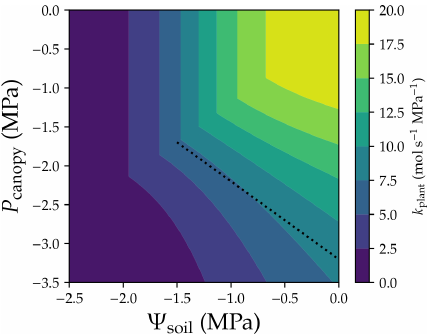
Figure 5. Whole-plant vulnerability surface. Whole-plant hydraulic conductance is computed using k plant = E . The (cid:57) soil − P canopy − ρgh dotted line plots the scenario when mean xylem water pressure is − 1 . 6MPa. The simulation is done assuming there is no drought legacy effect from previous xylem embolism. See Table 1 for the list of